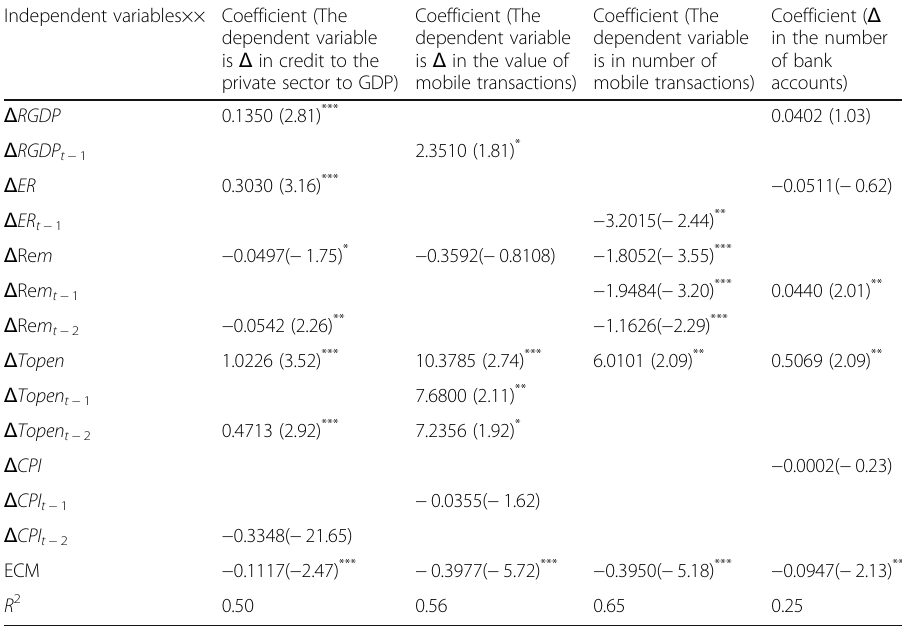
Table 7 Econometric results for the error correction model Independent variables×× Coefficient (The